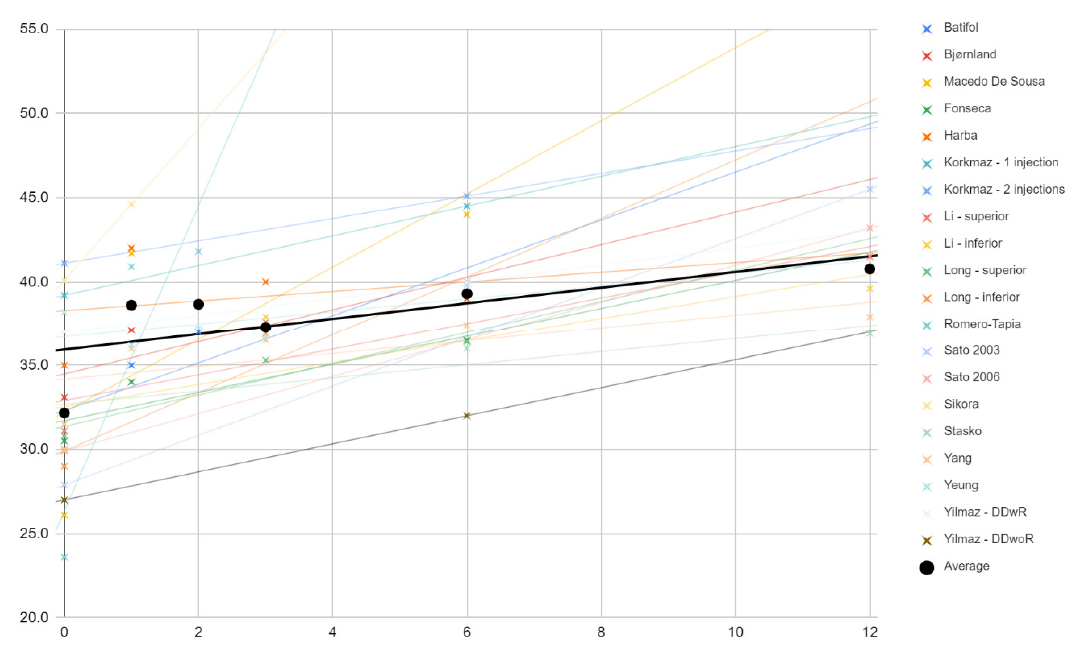
Figure 3. Change in the value of mandibular abduction (mm) over time (months). Description in the text.